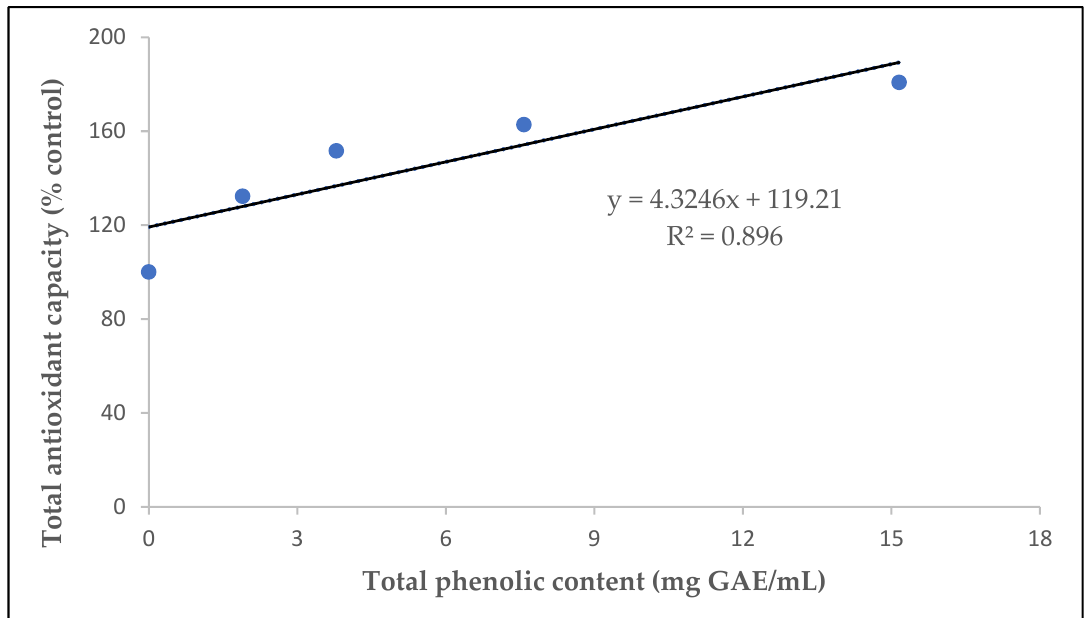
Figure 4. Correlation between the total phenolic content and total antioxidant capacity of the sports beverage.